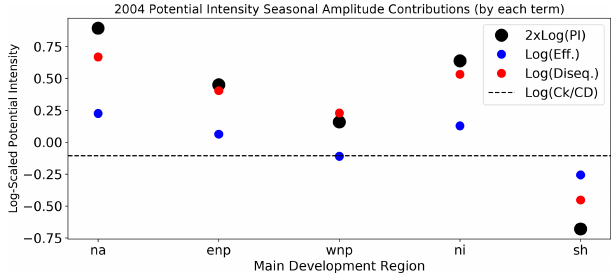
Figure 9. Seasonal amplitudes of each PI decomposition term (Eq. 16) in 2004 and each main development region, calculated with pyPI. Compare with Gilford et al. (2017), their Table 2. By con- vention, negative amplitudes indicate the associated seasonal cycle peaks in the boreal winter. For reference, the dashed black line in- dicates the magnitude and sign of the seasonally invariant log ( C k